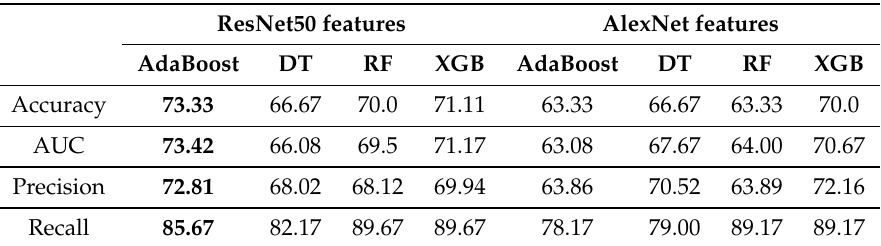
Table 7. Performance of the deep features extracted with two state-of-the-art deep neural networks. The results are computed evaluating the four classification algorithms that were used in the proposed pipeline in 10-fold cross validation. The largest performance is highlighted in bold.